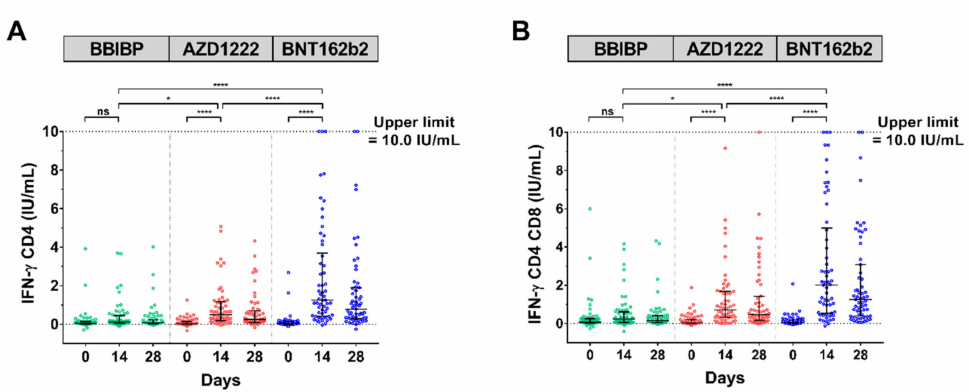
Figure 4. SARS-CoV-2-stimulating IFN-